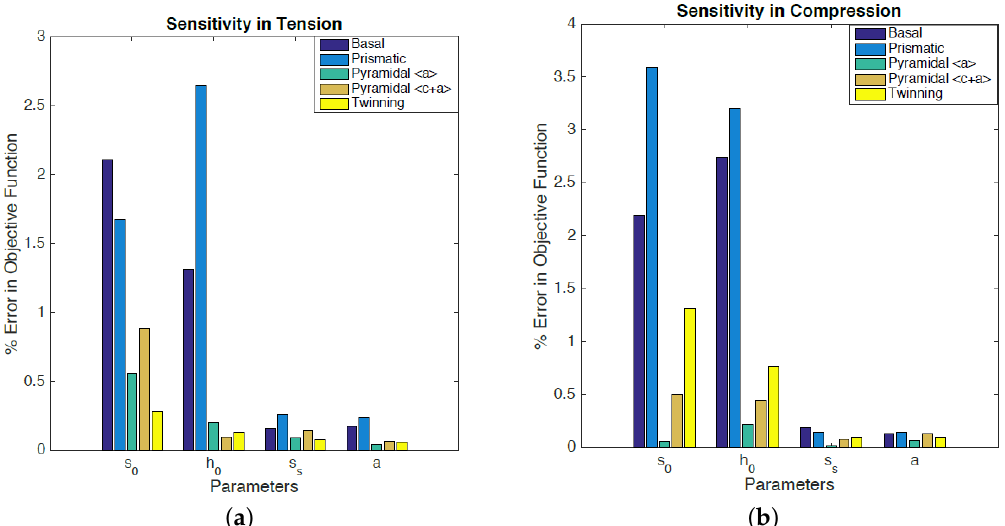
Figure 7. Sensitivity analysis results for optimum design parameters of Ti-7Al. ( a ) Tension results; ( b ) Compression